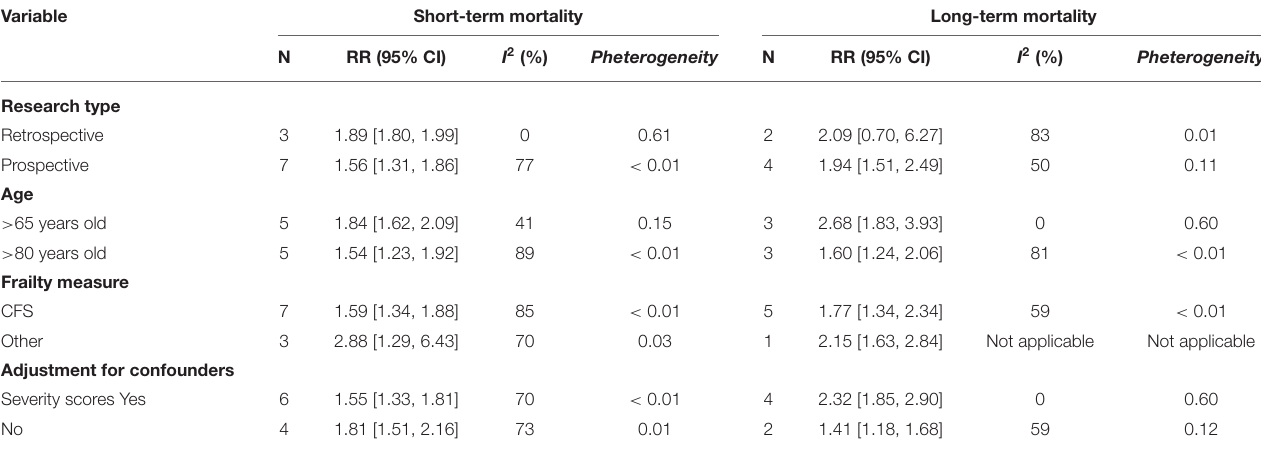
TABLE 2 | Subgroup analysis on the association between frailty and mortality.